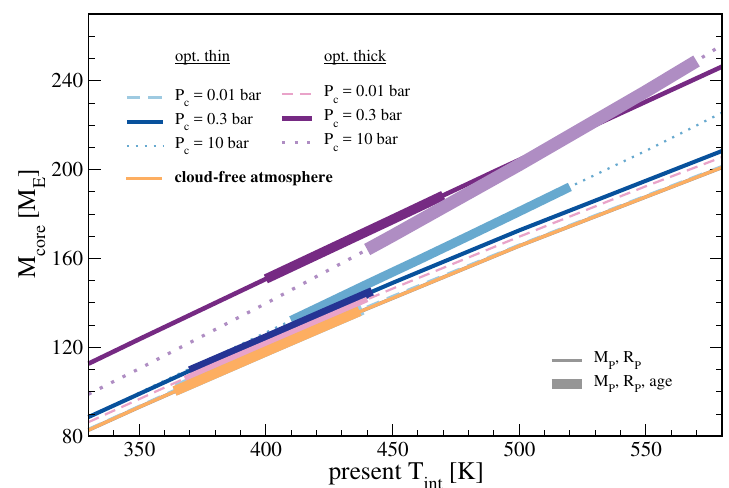
Figure 8. M core - T int relation for WASP-10b assuming cloud-free atmosphere (orange) and six different cloud decks in the atmosphere. Thin lines indicate the results obtained by M P , R P , thick bars highlight the solutions that also satisfy the age constraint.